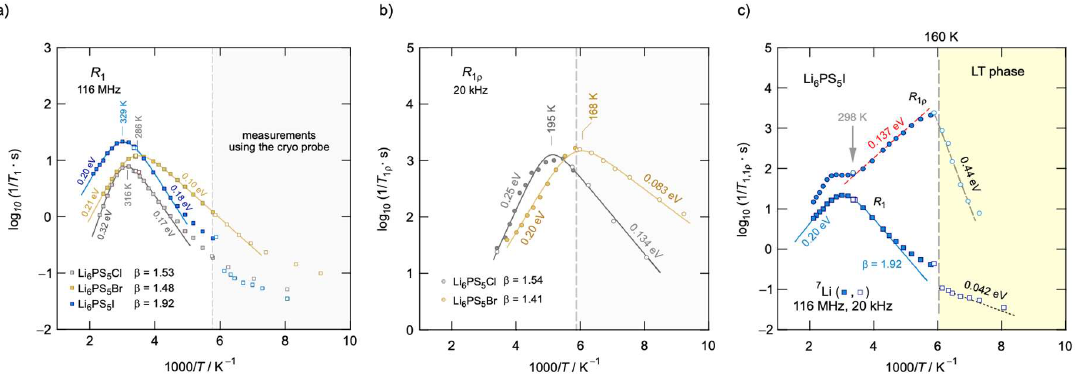
Figure 15. Arrhenius relaxation plots of Li 6 PS 5 X in the ( a ) lab frame of reference, ( b ) rotating frame of reference of 20 kHz, and ( c ) combined relaxation plots of Li 6 PS 5 I [46] .